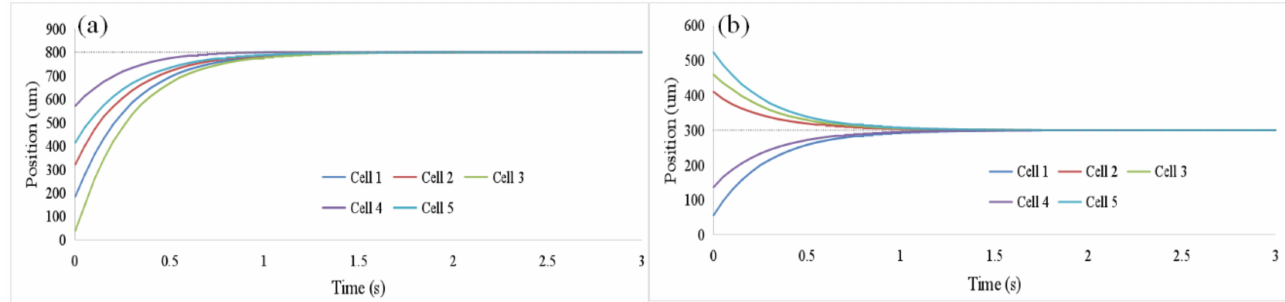
Figure 9. Oocyte translation control result. ( a ) X -axis direction control results. ( b ) Y -axis direction control